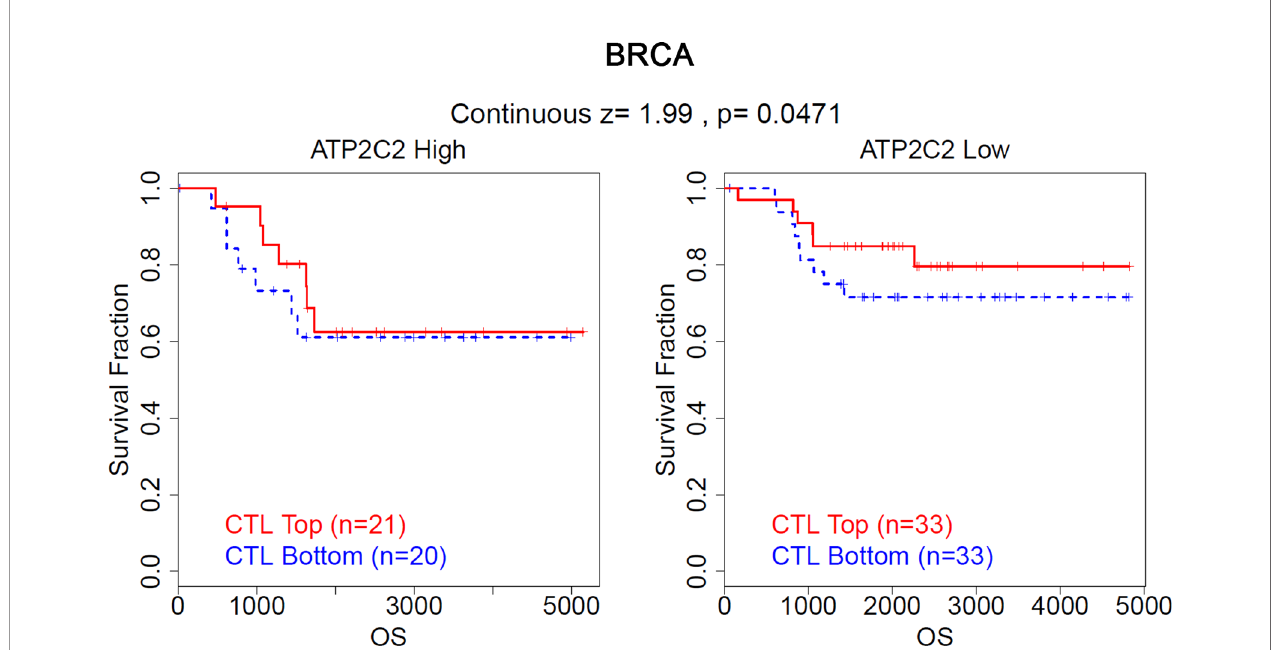
FIGURE 9 | Validation of ATP2C2 as a regulator of tumor immune escape. The association between the CTL level and OS for BRCA with different ATP2C2